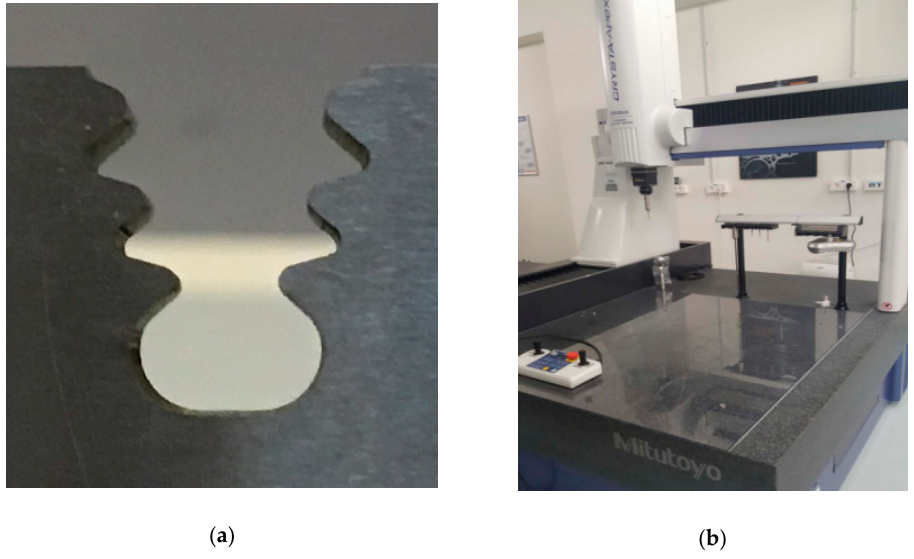
Figure 1. ( a ) Geometry of the fir-tree slot ( b ) Coordinate Measuring Machine (CMM).